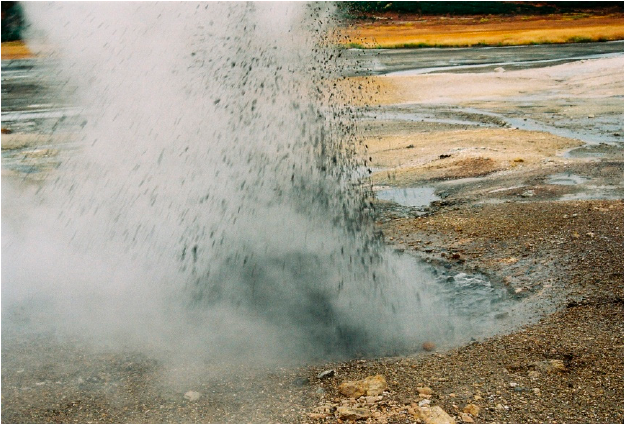
Figure A2. Shaman geyser eruption in 2010 (photo by G. Karpov, south view).